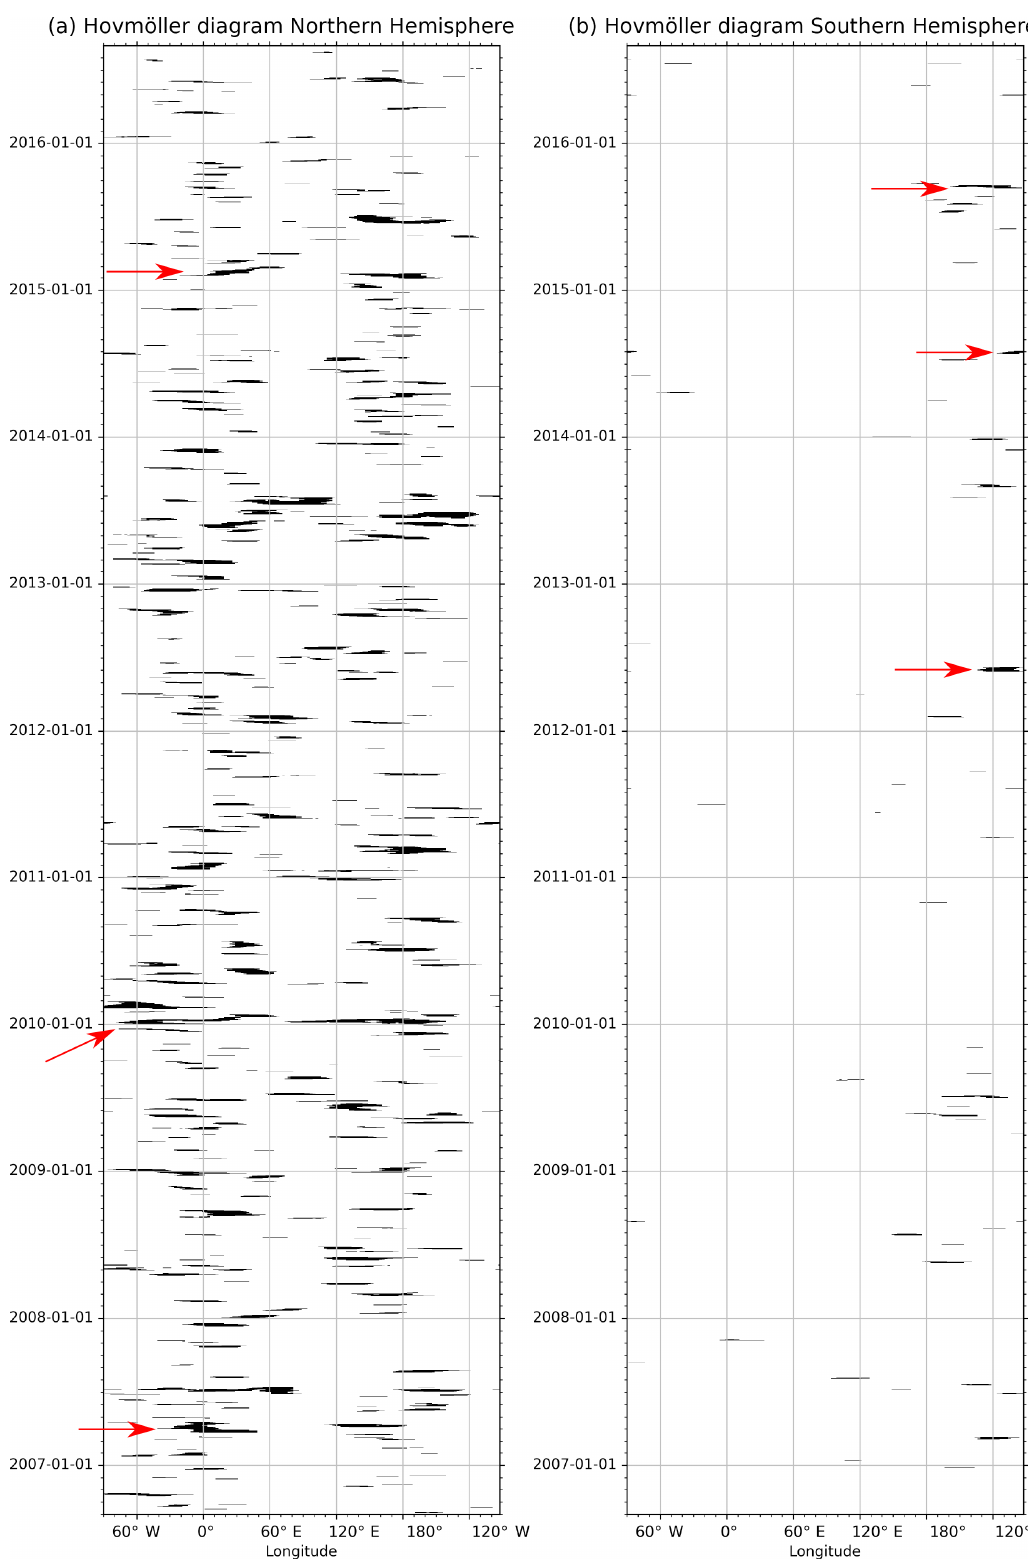
Figure 2. Hovmöller diagram of blocking as function of time over longitudes for the (a) Northern and (b) Southern Hemisphere based on the RO record for the period September 2006 to August 2016. Red arrows mark the three longest blocking events in each